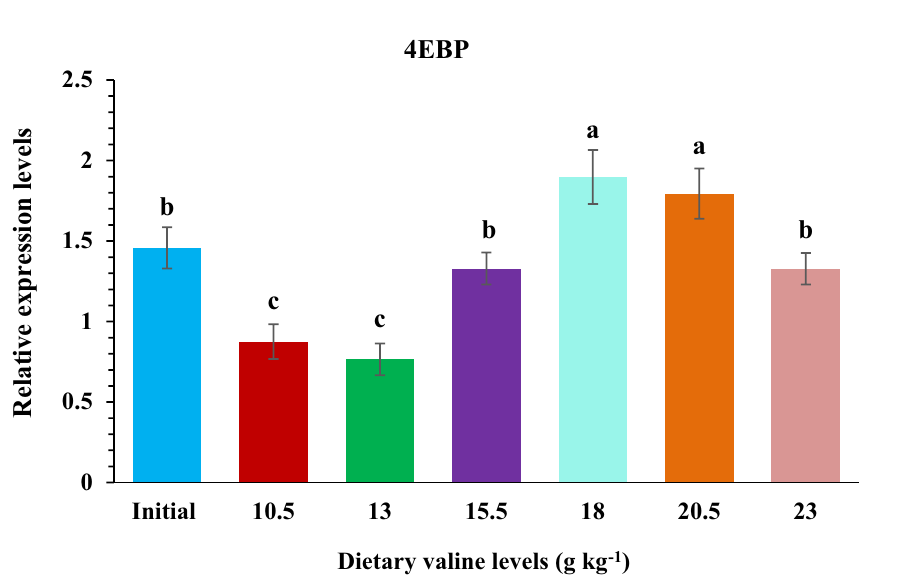
Figure 6. Relative expression level of elF-4E binding protein (4E-BP) gene in the muscle of rainbow trout, Oncorhynchus mykiss fingerlings fed varied dietary Val levels (g kg −1